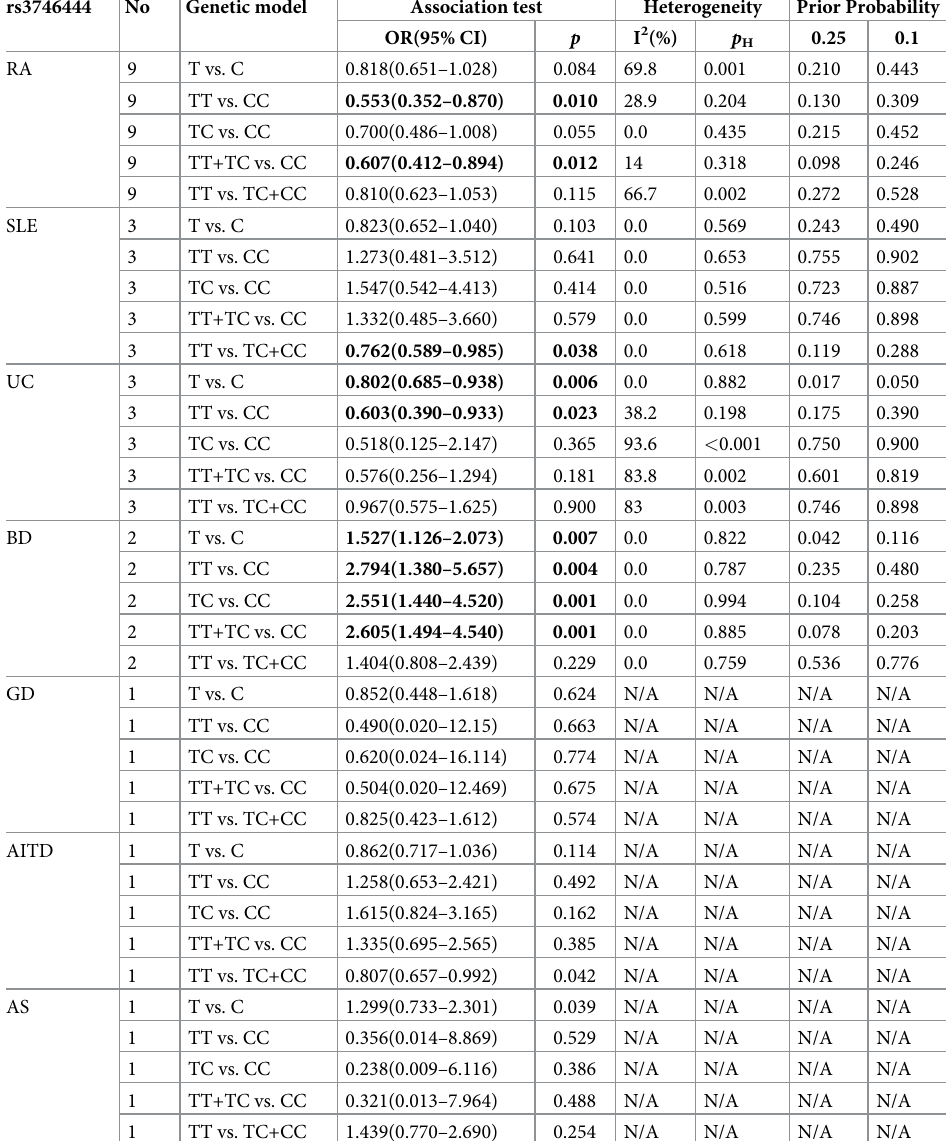
Table 4. The result of subgroup analysis by